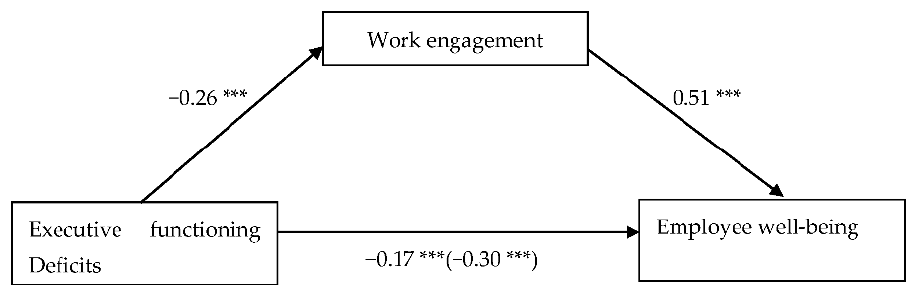
Figure 1. Mediation model of work engagement in the relationship between executive functioning deficits and employee well-being while controlling the effect of self-rated creativity. Note. n = 314 (imputed). Reported values are standardized coefficients. The total effect was shown in parentheses. The standardized indirect effect was − 0.13, SE = 0.01, 95% CI [ − 0.15, − 0.11]; *** p < 0.001.